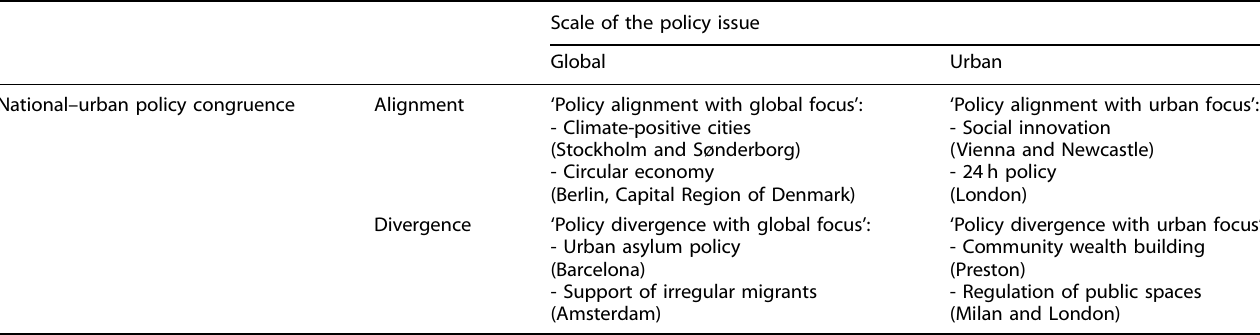
Table 1. Types of urban sustainable development